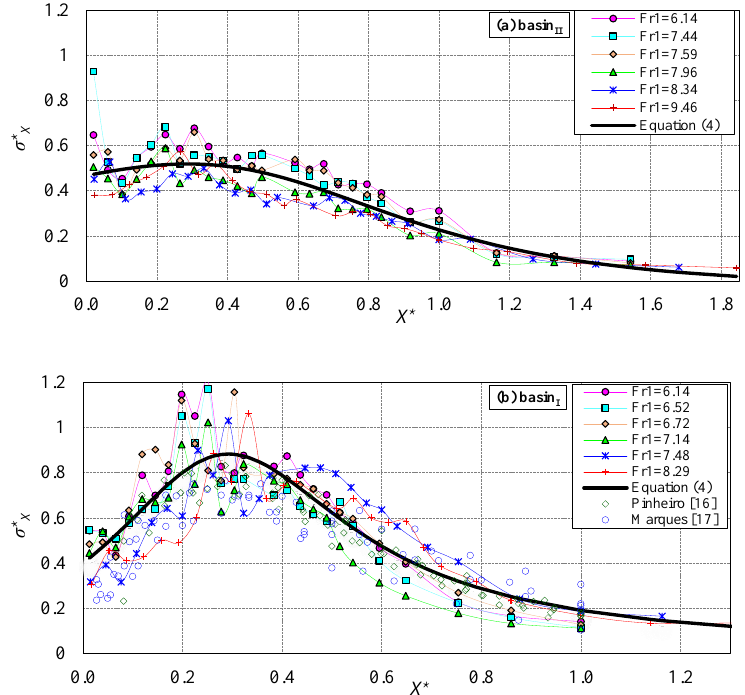
Figure 7. Distribution of the experimental and estimated values of σ * X : ( a ) basin II ; ( b ) basin I . Table 3. Range of σ * X max values and the position of X * σ max .